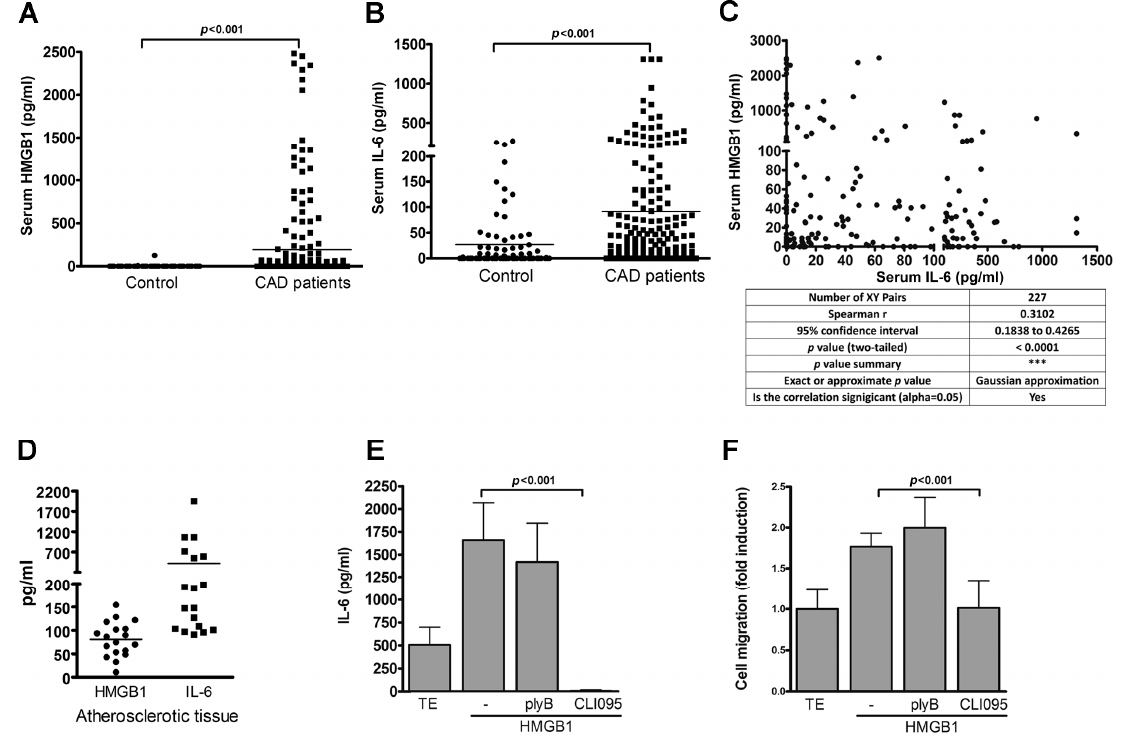
Figure 7. TLR4 endogenous ligand HMGB1 induces IL-6 production and VSMC migration. ( A ) Serum HMGB1 concentrations in CAD patients ( n = 227) and healthy subjects ( n = 54). p < 0.001 vs. control; ( B ) Serum IL-6 concentrations in CAD patients ( n = 227) and healthy subjects ( n = 80) were measured by ELISA. p < 0.001 vs. control. Statistical analyses in A-B were performed using the t -test; ( C ) Correlation between serum HMGB1 and serum IL-6 in CAD patients ( n = 227). Spearman’s rank correlation coefficient ( r = 0.3102, p < 0.0001). All values are expressed as means ± SD; ( D ) Amounts of HMGB1 and IL-6 in the atherosclerotic tissue of CAD patients were measured by ELISA; ( E , F ) VSMCs were pretreated with plyB or CLI-095 for 30 min, then stimulated with HMGB1 (50 µ g/mL) for 24 h; ( E ) IL-6 levels in culture supernatants were measured by ELISA; ( F ) VSMC migration was measured by the transwell assays. p < 0.001 vs. HMGB1. Data in E , F represent mean ± SD of three experiments. Statistical analyses in E – F were performed using the one-way